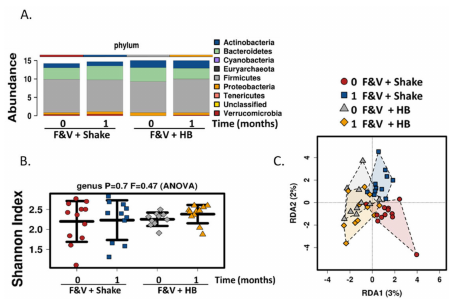
Figure 3. Microbiome abundance and diversity with consumption of the Complete ® high-fiber meal replacement drink (Shake) + FVC. ( A ) Fecal microbiota taxonomic abundance (phylum level) for the FVC+Shake vs. FVC+HB groups prior (0) and one month of supplementation (1). No significant differences were detected. ( B ) Scatterplot showing differences in α -diversity determined by Shannon index and ( C ) redundancy analysis (RDA) plot demonstrating β -diversity at genus level of the fecal microbiome prior (0) and after one month of Shake supplementation (1). No significant differences were detected. ( n = 14, FVC + Shake; n = 12; FVC + HB) FVC, dried fruit and vegetable supplement; HB, habitual